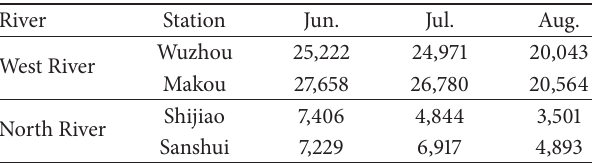
Table 6: Average monthly flow in West River and North River in flood season (units: m 3